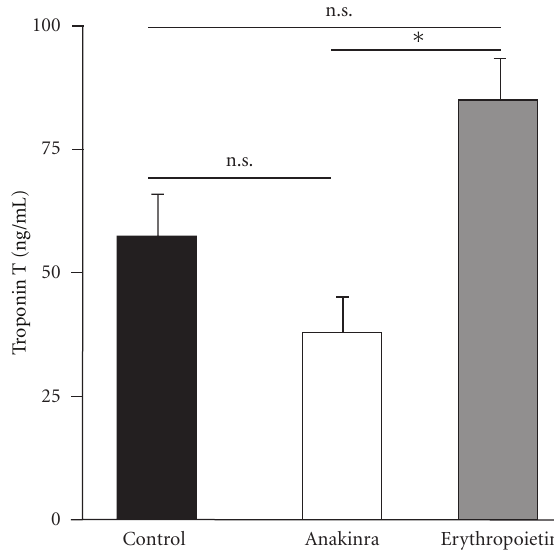
Figure 2: Impact of Anakinra and erythropoietin on troponin T levels. One-time intravenous administration of Anakinra prior to reperfusion resulted in a significant reduction of troponin T levels compared to animals receiving erythropoietin ( P < 0 . 05, N = 4/group), whereas no significant di ff erence compared to rats receiving saline solution (control) was